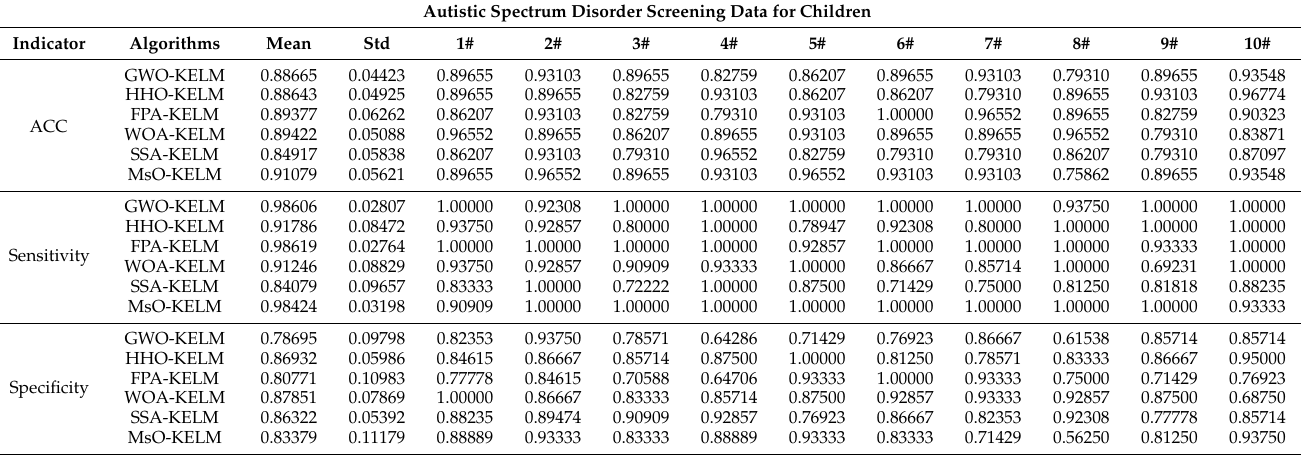
Table 8. The prediction results on disease dataset Autistic Spectrum Disorder Screening Data for